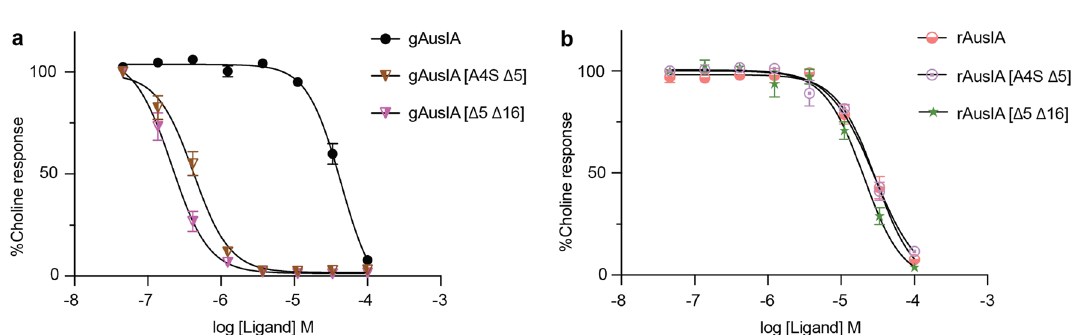
Figure 7. Functional characterisation of doubly-mutated gAusIA and rAusIA at human α7-containing nAChRs. Concentration response curves for gAusIA ( a ), rAusIA ( b) and their analogues at α7-containing nAChRs on SH-SY5Y cells are shown. Data represent mean ± SEM of triplicate data from three independent experiments.